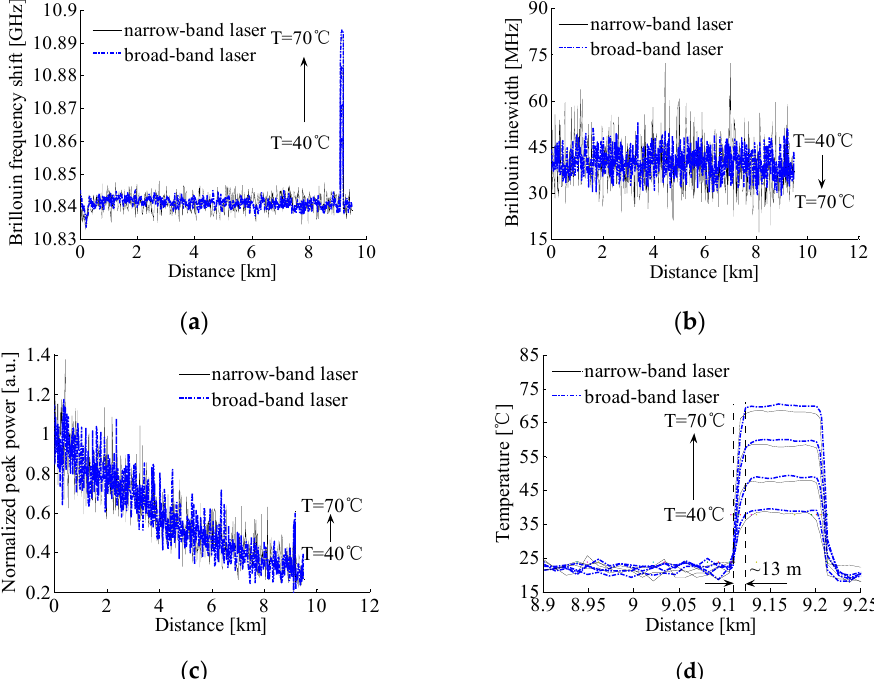
Figure 10. Distribution of Brillouin signals and demodulated temperature along the fiber based on the self-heterodyne detection: ( a ) Brillouin frequency shift; ( b ) Brillouin linewidth; ( c ) Brillouin peak power; and ( d ) temperature. Table 3. Measured averaged BFS and demodulated temperature of the heated fiber at different thermostatic water bath temperatures.